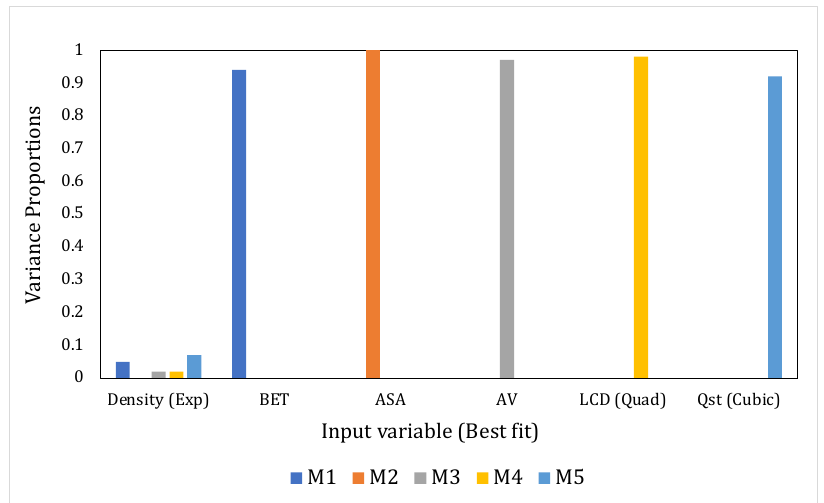
Figure 6. Variance proportion distribution corresponding to the second term in the five MLR models, corresponding to the best-fitting model of each input variable with GD that was obtained from the SLR analysis.